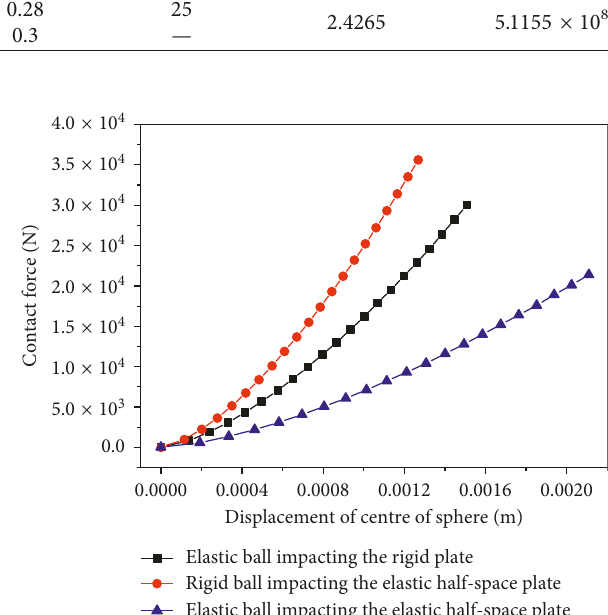
Figure 4: Displacement of centre of sphere.